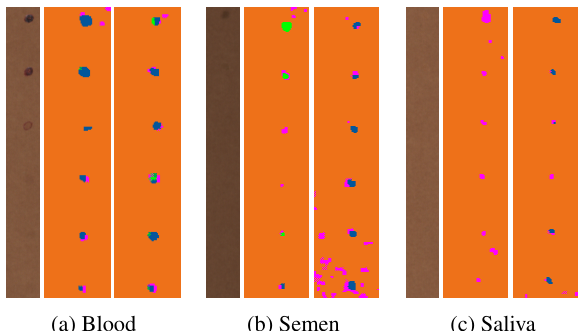
Figure 6: Results of multiclass classification postprocessed by MRF. Columns for each specimen: Left - RGB. Middle - RF. Right - PCA and LDA followed by ML. Colours as given in Fig- ure 5. (Best viewed in